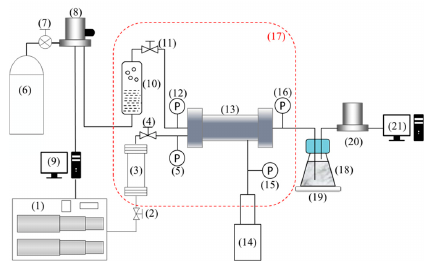
Figure 1. Schematic diagram of experimental apparatuses: ( 1 ) Syringe pump; ( 2 ), ( 4 ), ( 11 ) Valve; ( 3 ) Synthetic brine cylinder; ( 5 ), ( 12 ), ( 15 ), ( 16 ) Pressure transducer; ( 6 ) Nitrogen cylinder; ( 7 ) High